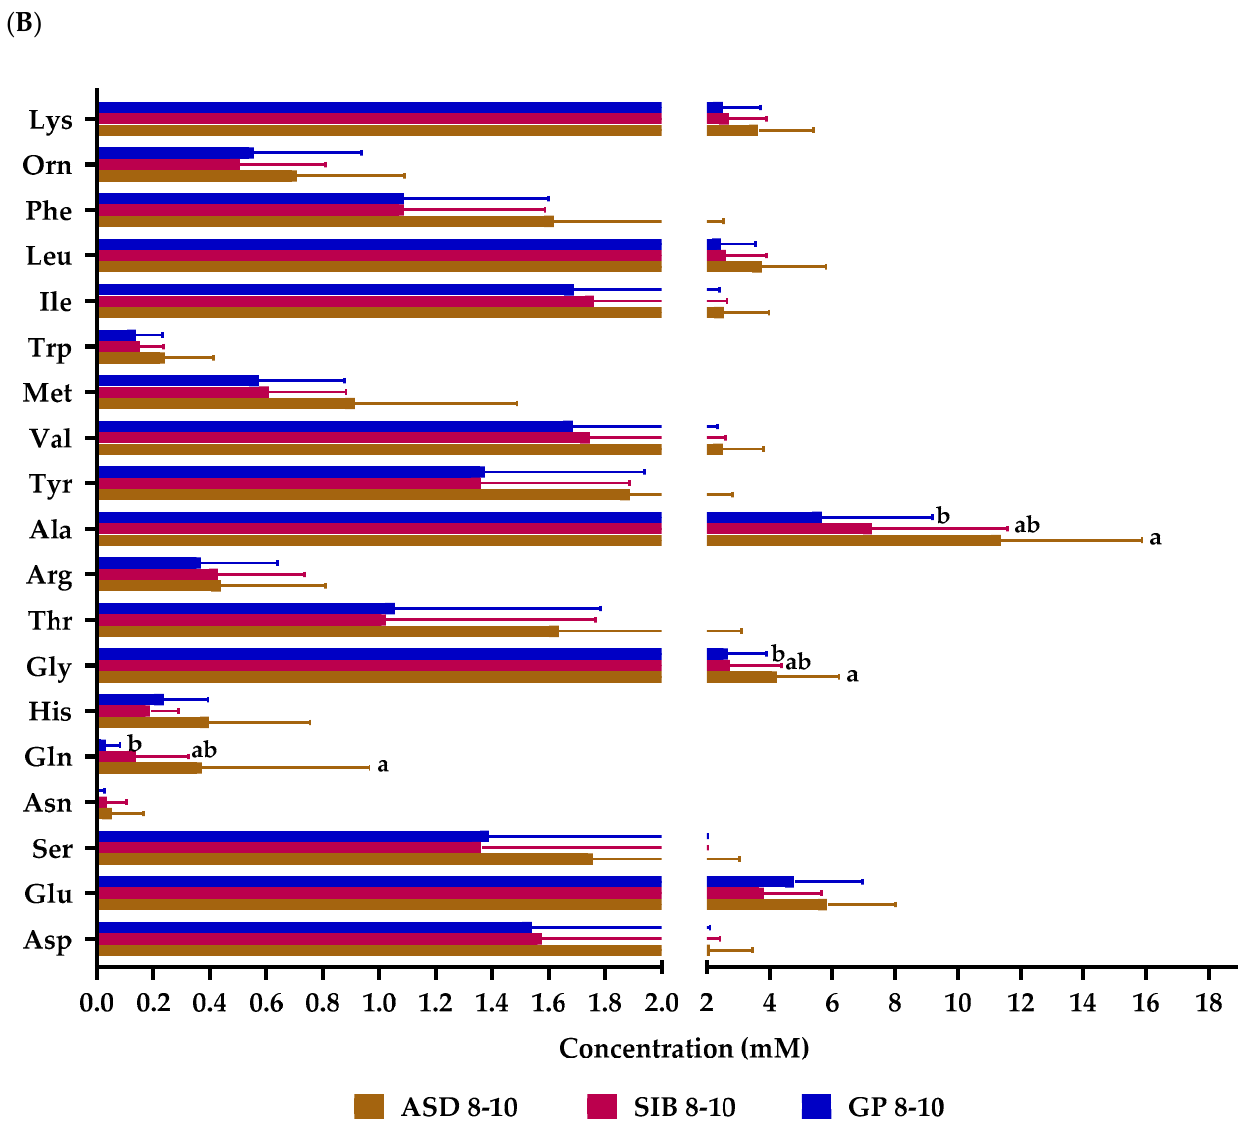
Figure 2. Fecal levels of amino acids in samples from autistic children (ASD), their siblings (SIB), and children from the general population (GP) in Tunisia stratified by age: ( A ) 4–7 years, ( B ) 8–10 years. Asp: aspartate; Glu: glutamate; Ser: serine; Asn: asparagine; Gln: glutamine; His: histidine; Gly: glycine; Thr: threonine; Arg: arginine; Ala: alanine; Tyr: tyrosine; Val: valine; Met: methionine; Trp: tryptophan; Ile: Isoleucine; Leu: leucine: Phe: phenylalanine; Orn: Ornithine; Lys: lysine. Bars represent mean values and horizontal lines on the bars represent standard deviation. Different letters (a, b, ab) indicate significant differences among groups of children for each amino acid ( p < 0.05).